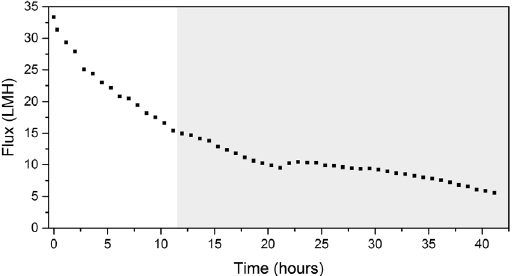
Figure 1. Flux decrease during the first 42 h of filtration time (Observation period by Supplementary Video 1 is highlighted in grey color).